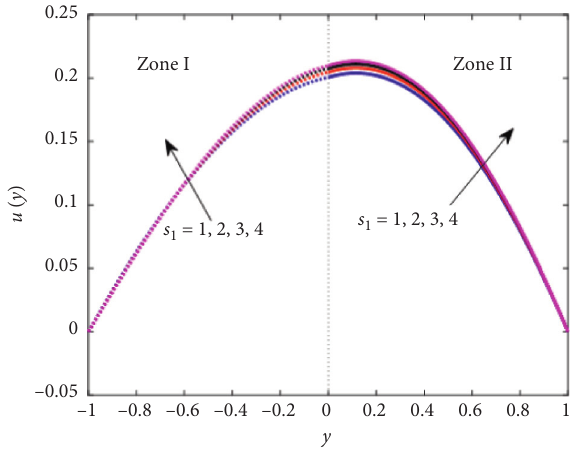
Figure 3: Velocity profiles for various s